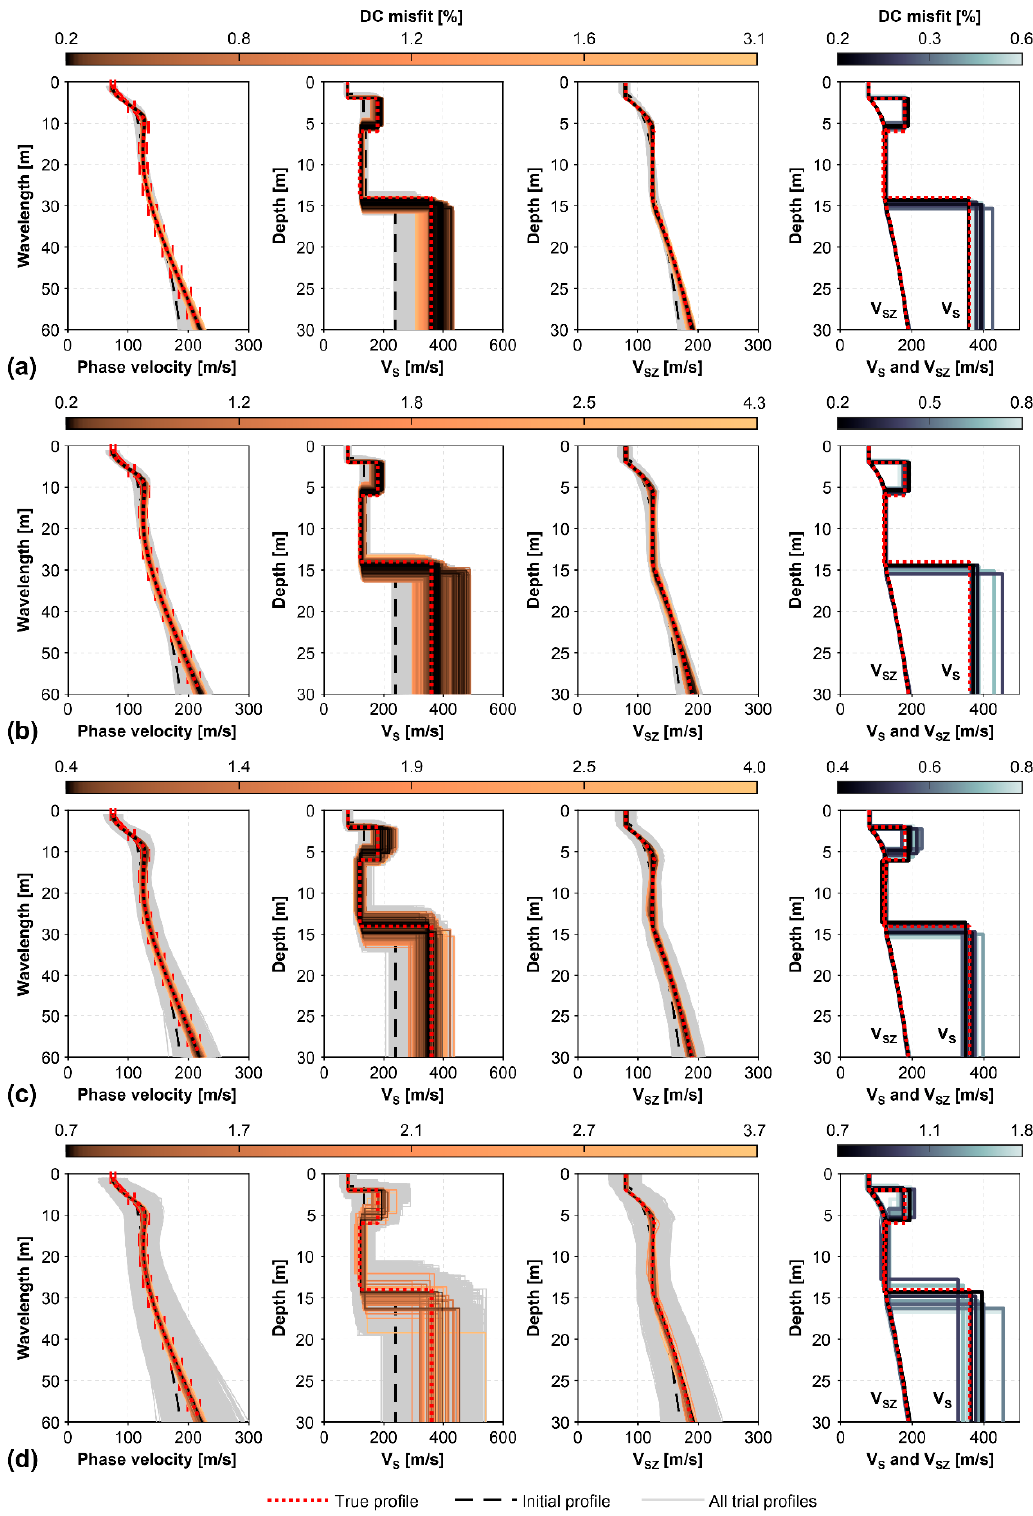
Figure 10. Inversion of the unperturbed synthetic dispersion curve from model C. A geologic structure consisting of four layers (incl. the half-space) was assumed. The search-control parameters were specified as ( a ) b = 2.5, ( b ) b = 5, ( c ) b = 10 and ( d ) b = 20. Gray areas display all sampled models. Profiles whose dispersion curves deviate less than 5% from the synthetic curve at all wavelengths are shown using a color scale defined based on dispersion misfit values. The lowest DC misfit V S - and V SZ -profiles within each independent set of 1000 iterations are shown in the column furthest to the right.